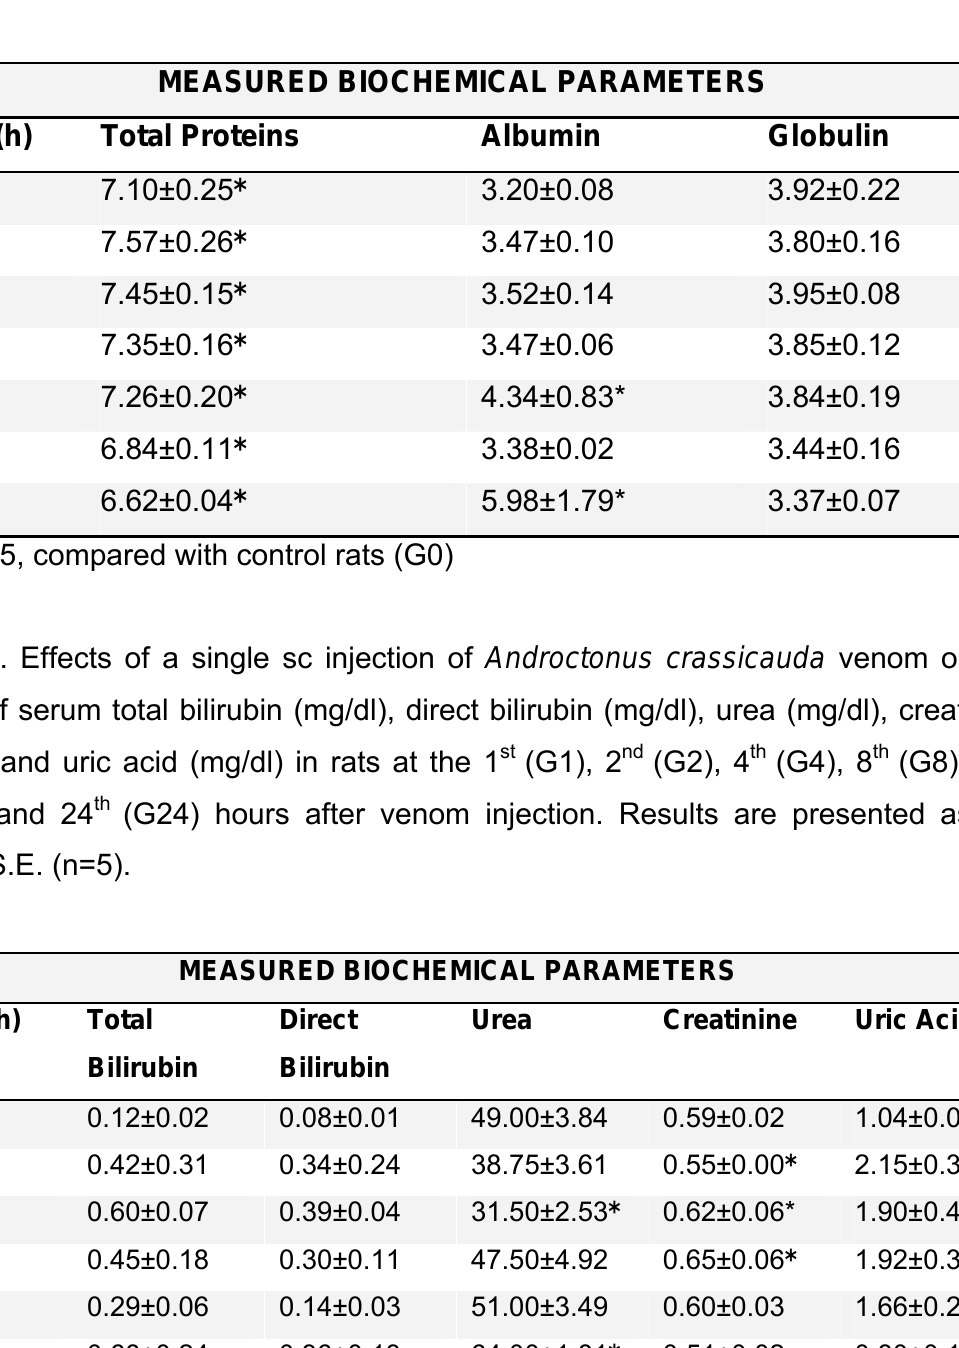
Table 1. Effects of a single sc injection of Androctonus crassicauda venom on the levels of serum total proteins (g/dl), albumin (g/dl) and globulin (g/dl) in rats at the 1 st (G1), 2 nd (G2), 4 th (G4), 8 th (G8), 12 th (G12), and 24 th (G24) hours after venom injection. Results are presented as the mean±S.E. (n=5).